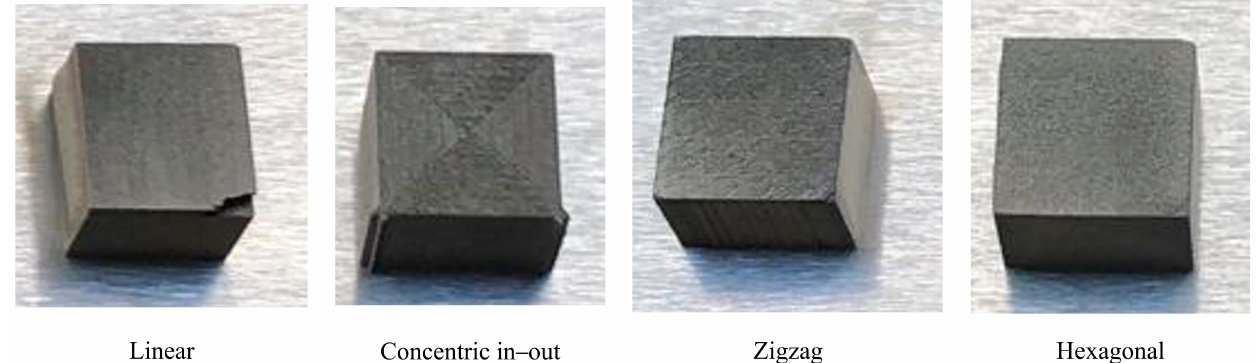
Figure 10. SiC samples printed using the process parameters obtained from the numerical model with different scanning strategies.